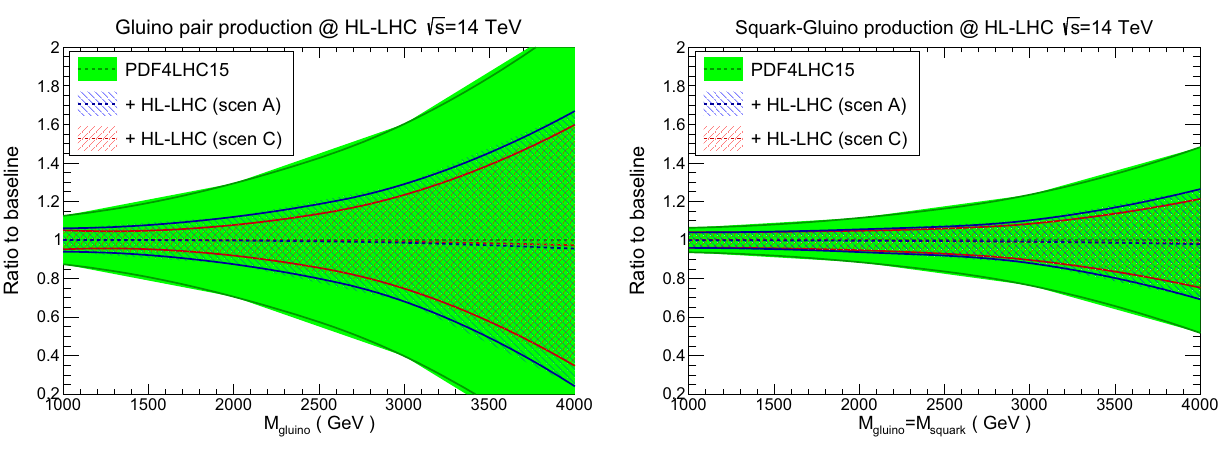
PDF4LHC15. We show the results corresponding to gluino pair pro- duction (left) and squark–gluino production (right). The cross sections have been evaluated with Pythia8.235 using leading–order matrix elements and the SLHA2 benchmark point as model